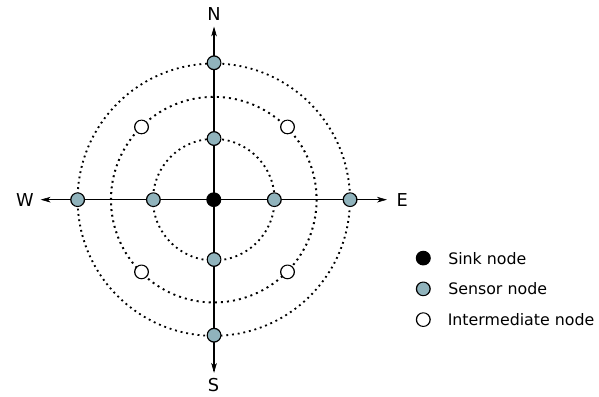
Figure 1. Example of WSN topology. Adjacent nodes may be up to 1km apart if the line of sight is available. Fig. 1: Example of WSN topology. Adjacent nodes may be up to 1Km apart if line-of-sight is available.